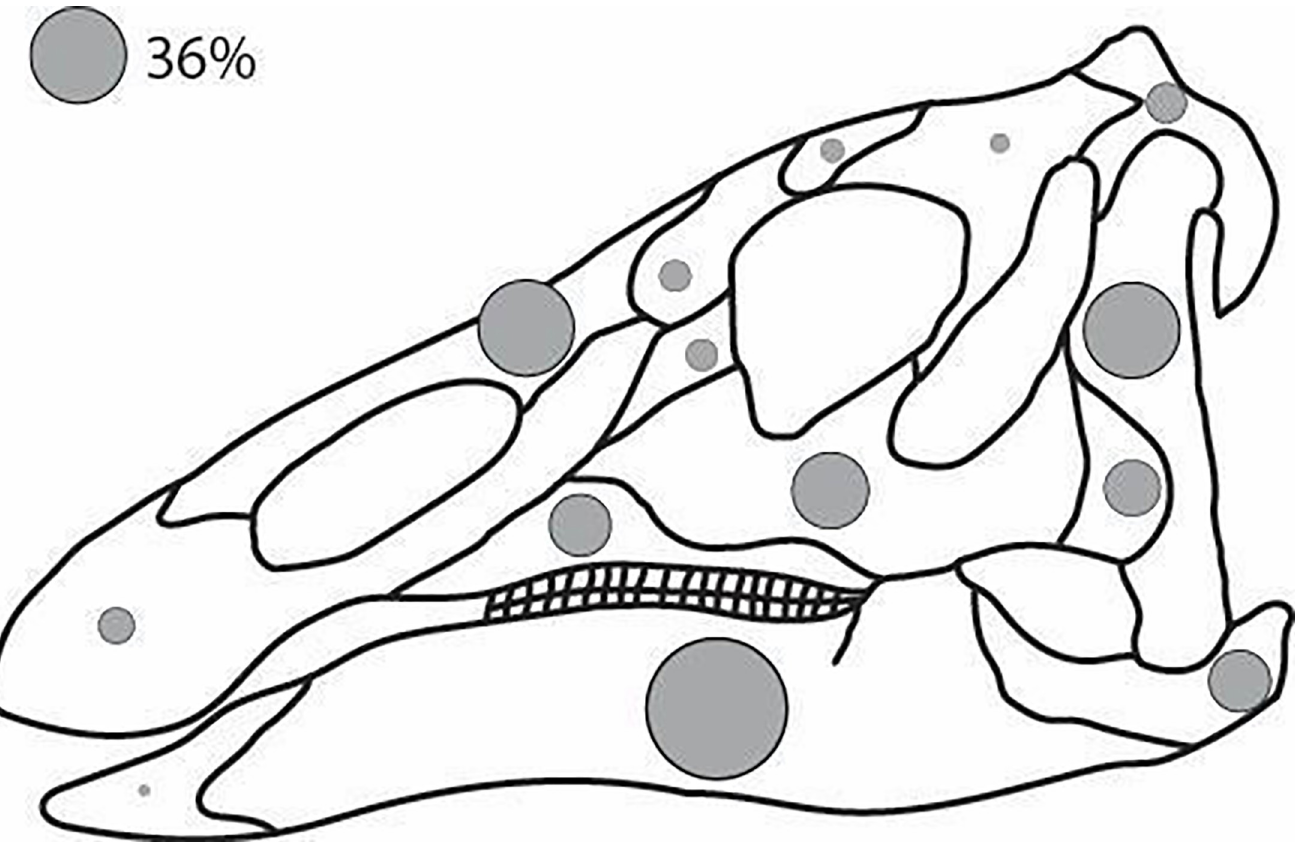
Fig 11. Relative number of Edmontosaurus cranial bones found that are over- (larger) or under- (smaller) represented compared to a 36% overall recovery rate in the bonebed.